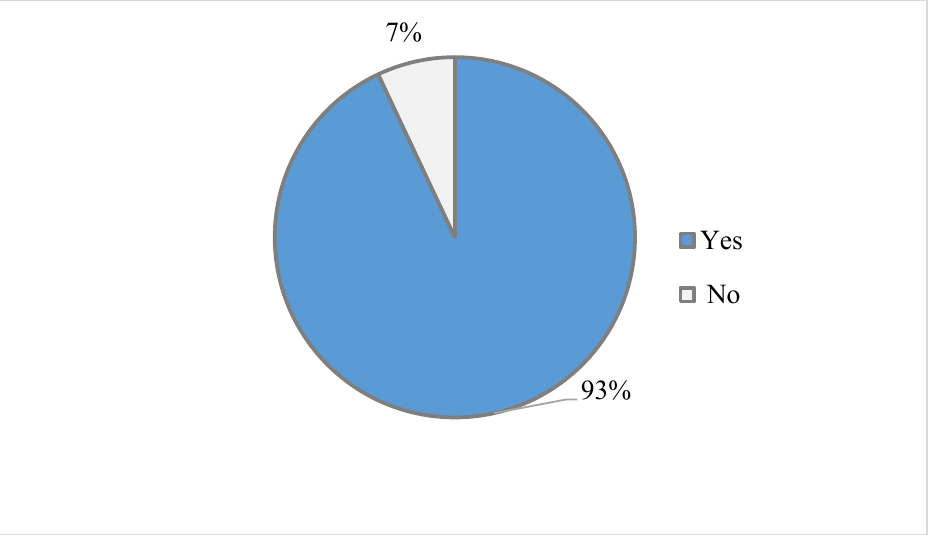
Figure 6 . Student responses when asked if they think technology enhances their